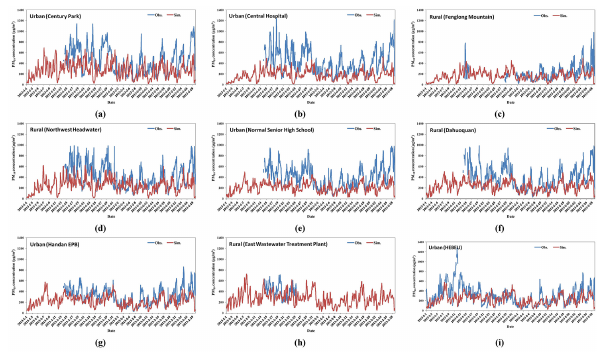
Fig. 6. The temporal variations of the observed and simulated PM 2 . 5 concentrations at the monitoring sites in Shijiazhuang, Xingtai, and Handan in January and February, 2013. (a–d) are the sites in Shi- jiazhuang, (e, f) are the sites in Xingtai, and (g–i) are the sites in Handan.